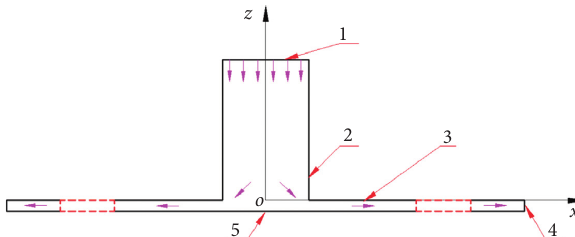
Figure 2: Sketch map of the cross section of the physical model for calculation of the gas film flow